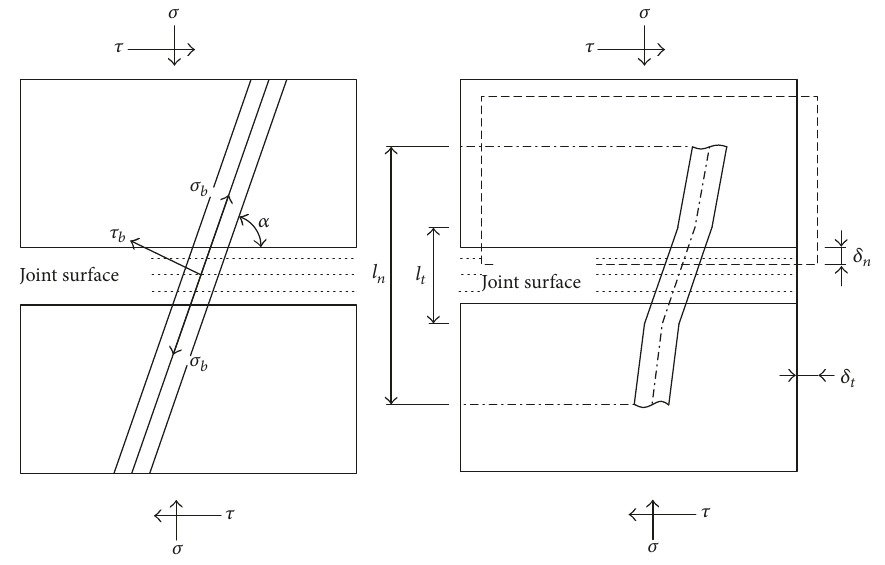
Figure 8: Deformations of the joint surface and bolt.